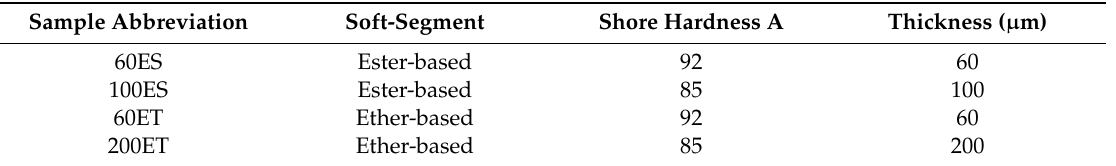
Table 1. Polyurethane films used in this research work, including their abbreviations and manufacturing properties from the